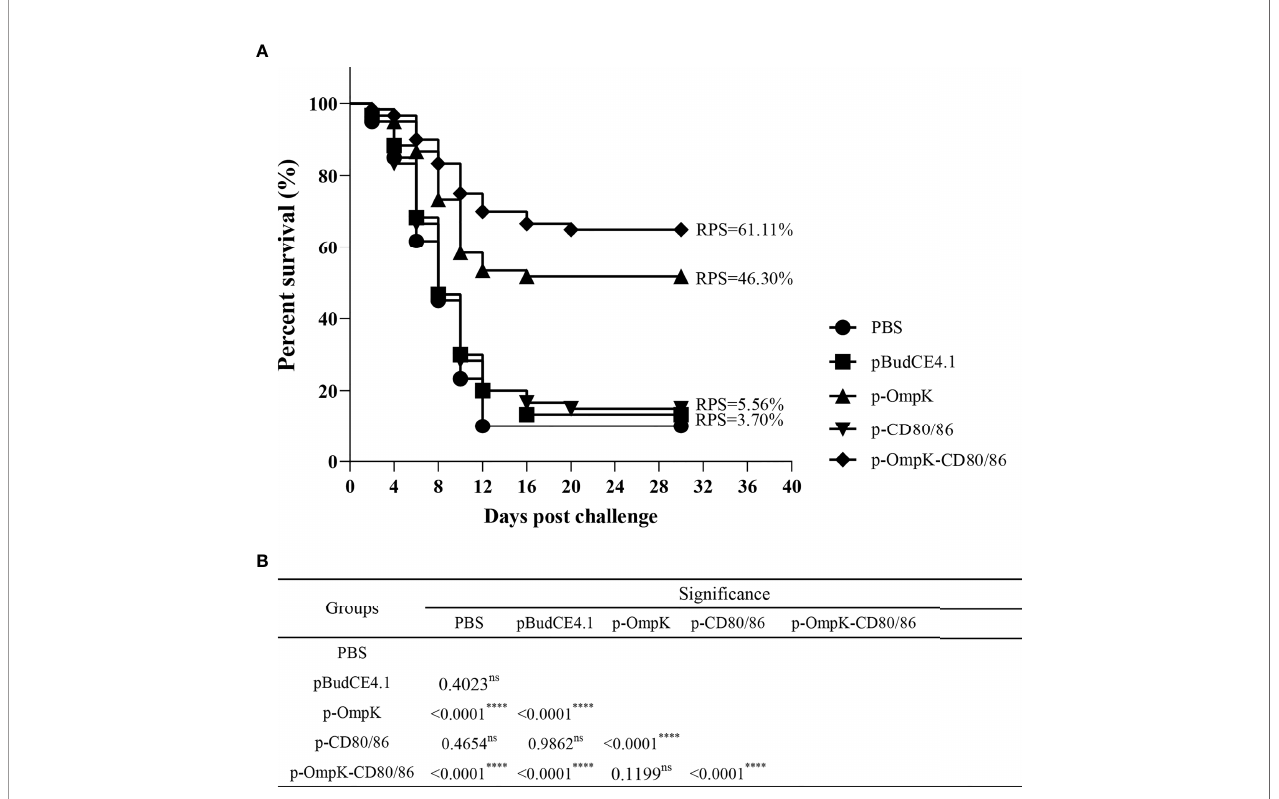
FIGURE 9 | (A) The percent survival of immunized fl ounder after challenge with live Vibrio anguillarum . RPS was calculated with a PBS group as the control. (B) The log rank method was used to detect any signi fi cant difference between the groups, and the “ **** ” indicates a statistically signi fi cant difference ( p < 0.0001), and “ ns ” indicates no statistically signi fi cant